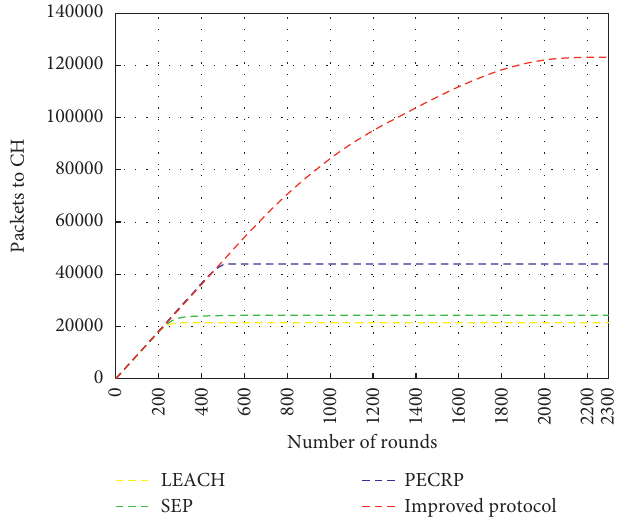
Figure 18: Comparison of packets sent to CHs from nodes with power